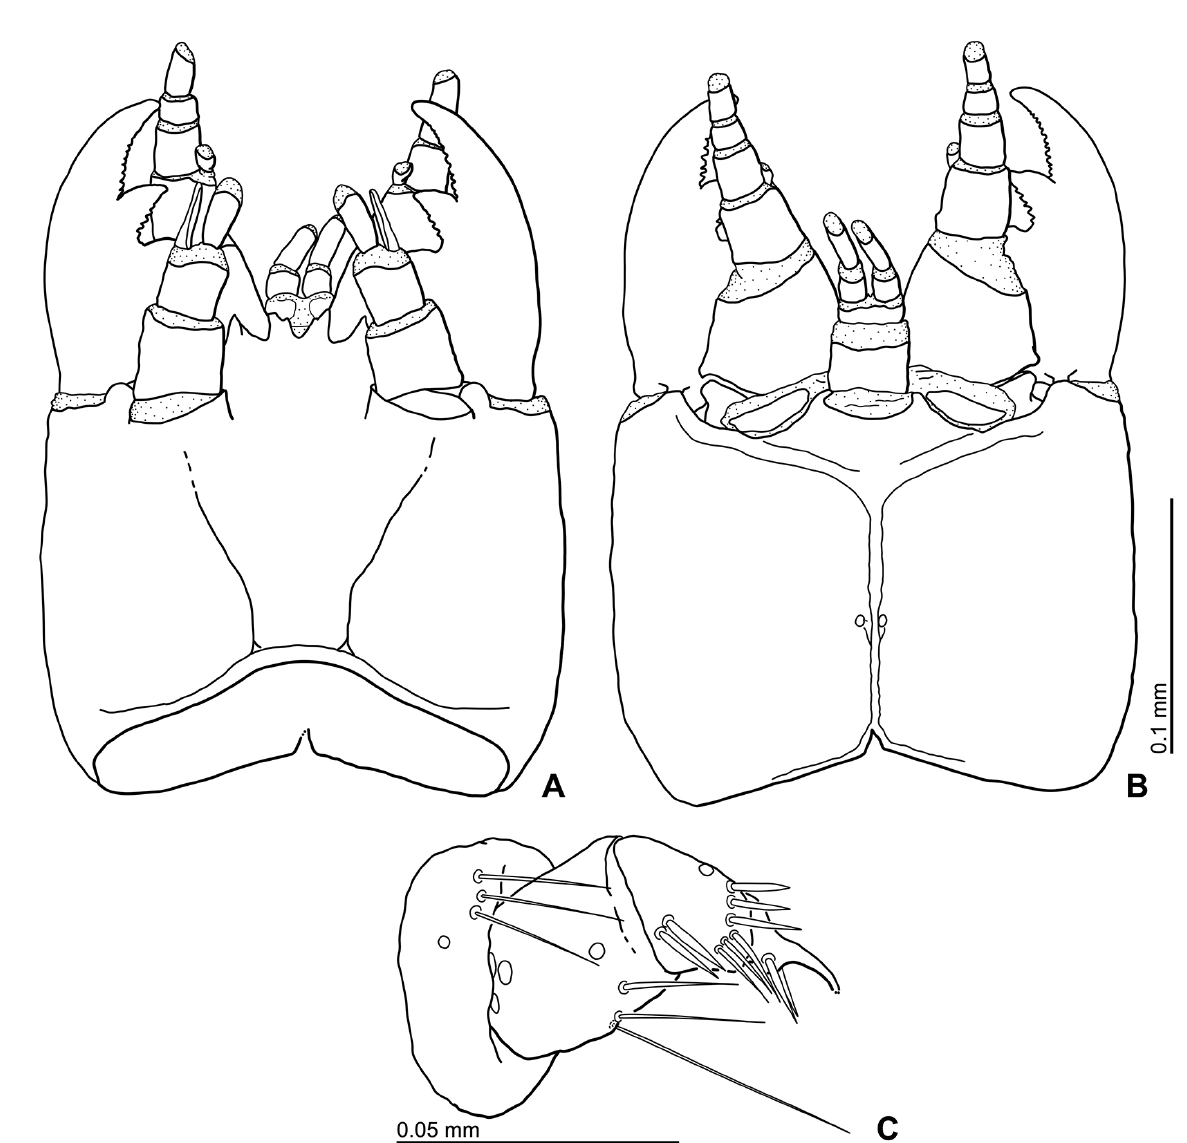
Figure 2. Larva of Psalitrus yamatensis Hoshina & Satô. A, B. Head, dorsal (A) and ventral (B) view; C. Foreleg, anterior